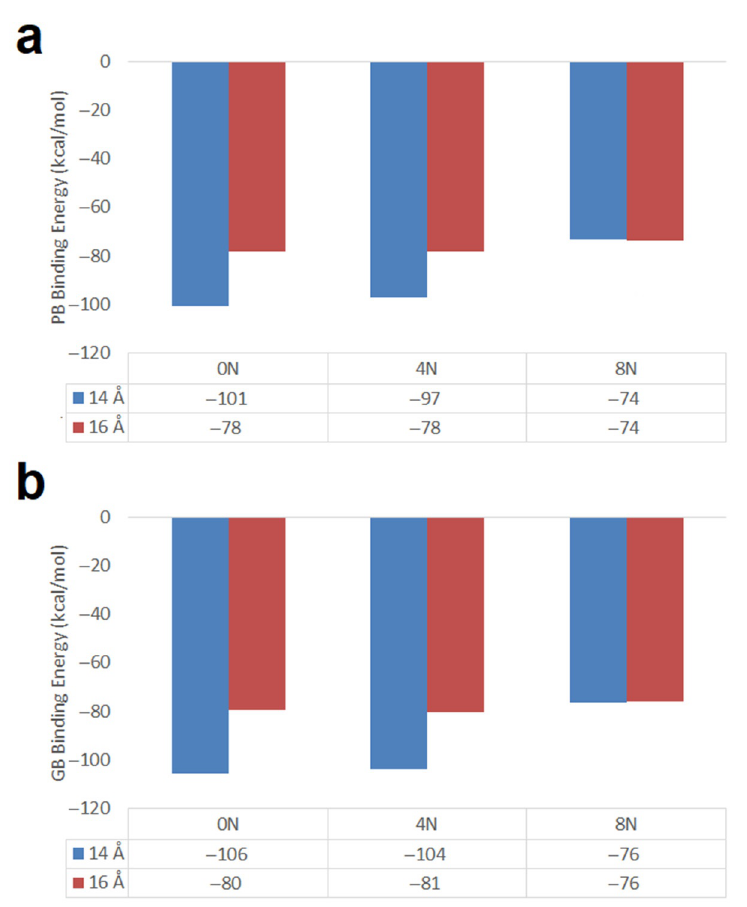
Figure 5. DOX-CNT binding energies for nitrogen-doped and undoped chiral nanotubes of 19 Å length with different diameter, having Hk2 defects and calculated with RESP charges for DOX. (a) PB binding energies; (b) GB binding energies. Blue is for 14 Å diameter and red is for 16 Å diameter.